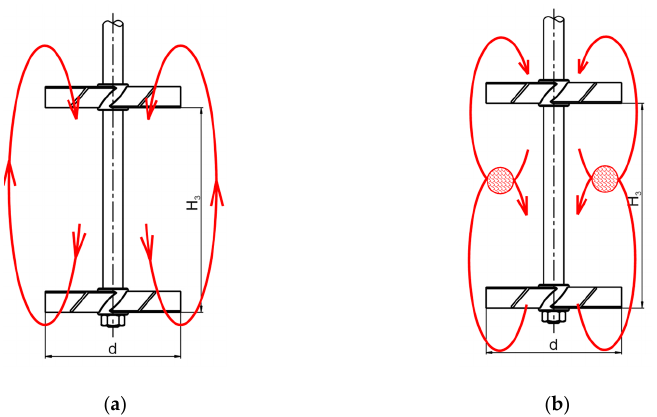
Figure 7. Flow in vessel equipped with multistage impeller [15]: ( a ) H 3 / d < 0.75, ( b ) H 3 / d = 0.75–1.25. Table 3. Dimensionless pumping capacities of agitators working on a common shaft—cylindrical vessel with dished bottom and four radial ba ffl es, D / d = 3 [15]. N